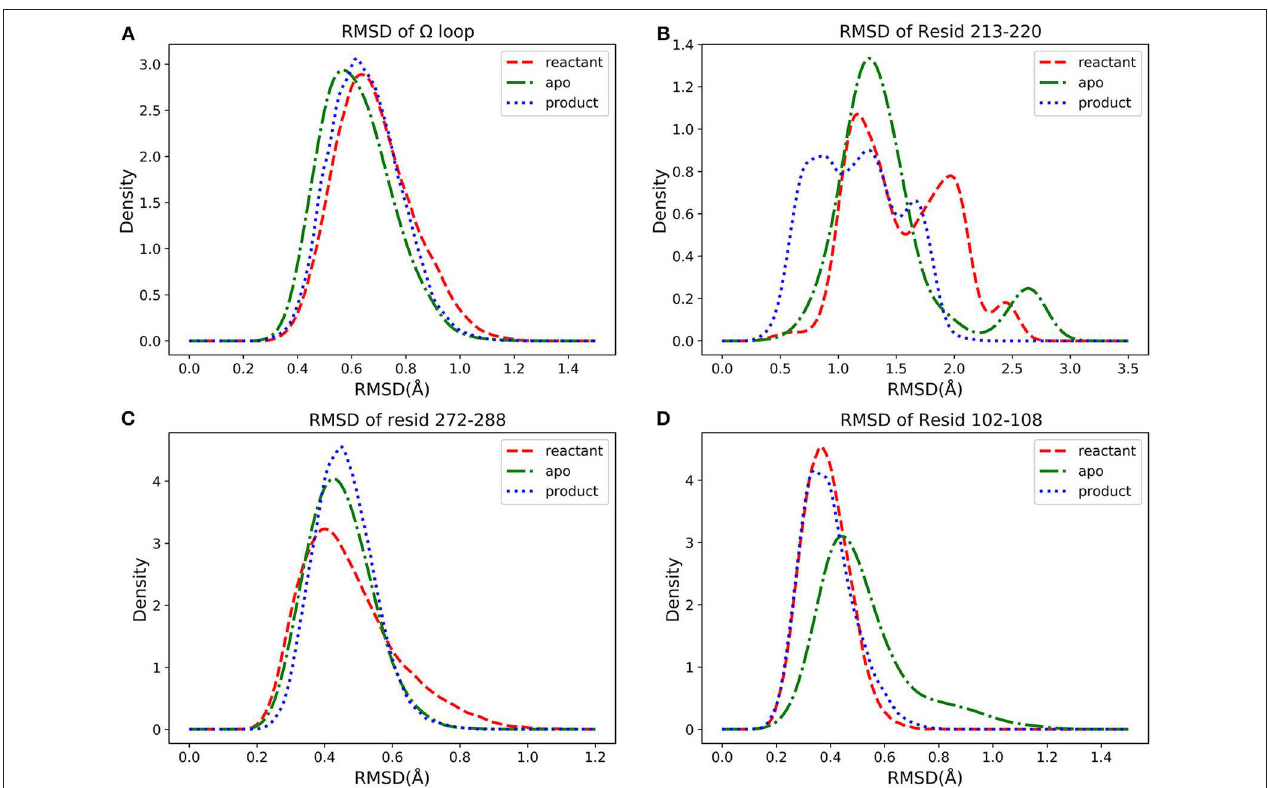
FIGURE 13 | The density distributions of residues groups’ RMSDs in apo (green dot dashed line), reactant (red dashed line) and product (blue dot line) states: (A) RMSD of (cid:127) loop (residues 163–180), (B) RMSD of residues 213–220, (C) RMSD of helix 12 (residues 272–288), (D) RMSD of residues